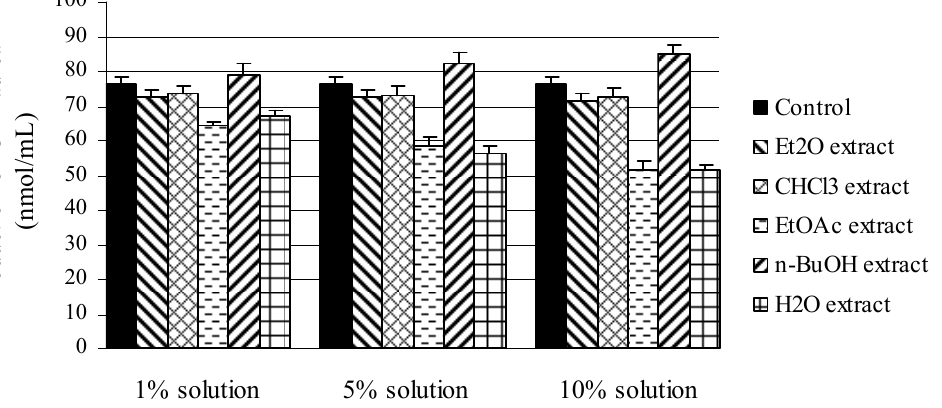
Figure 1. Inhibition of degradation of 2-deoxyribose by different extracts of